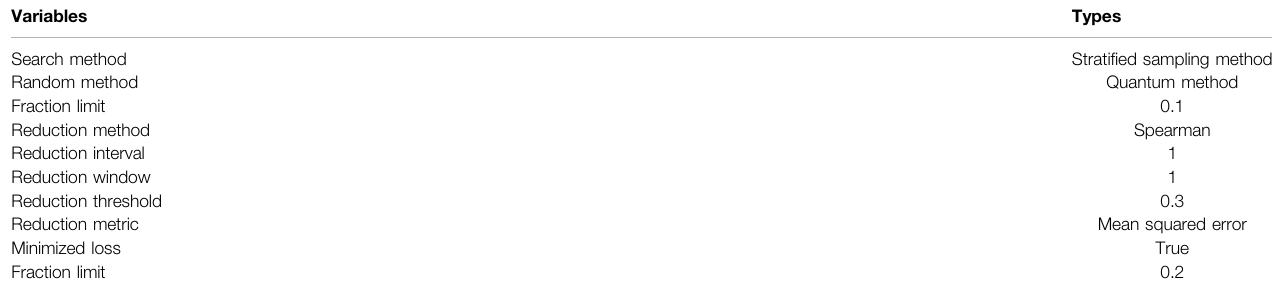
TABLE 5 | Variables for reducing computation